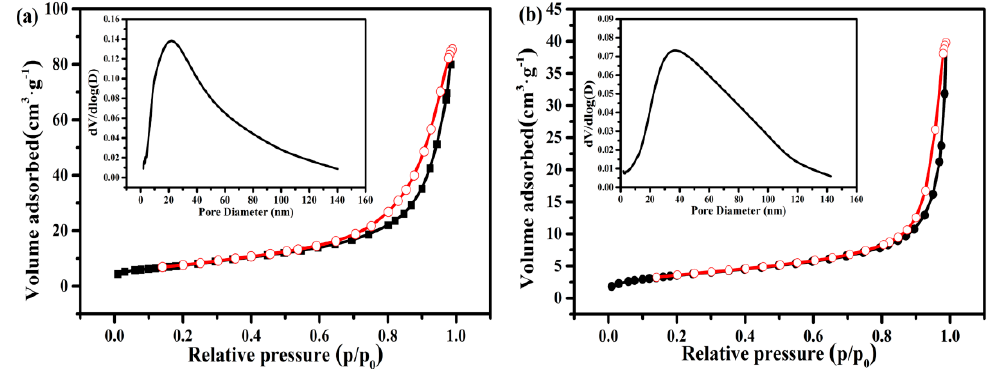
Figure 6. Nitrogen absorption-desorption isotherms and the pore-size distribution (inset) of ( a ) Bi 3 O 5 I 2 and ( b ) BiOI.